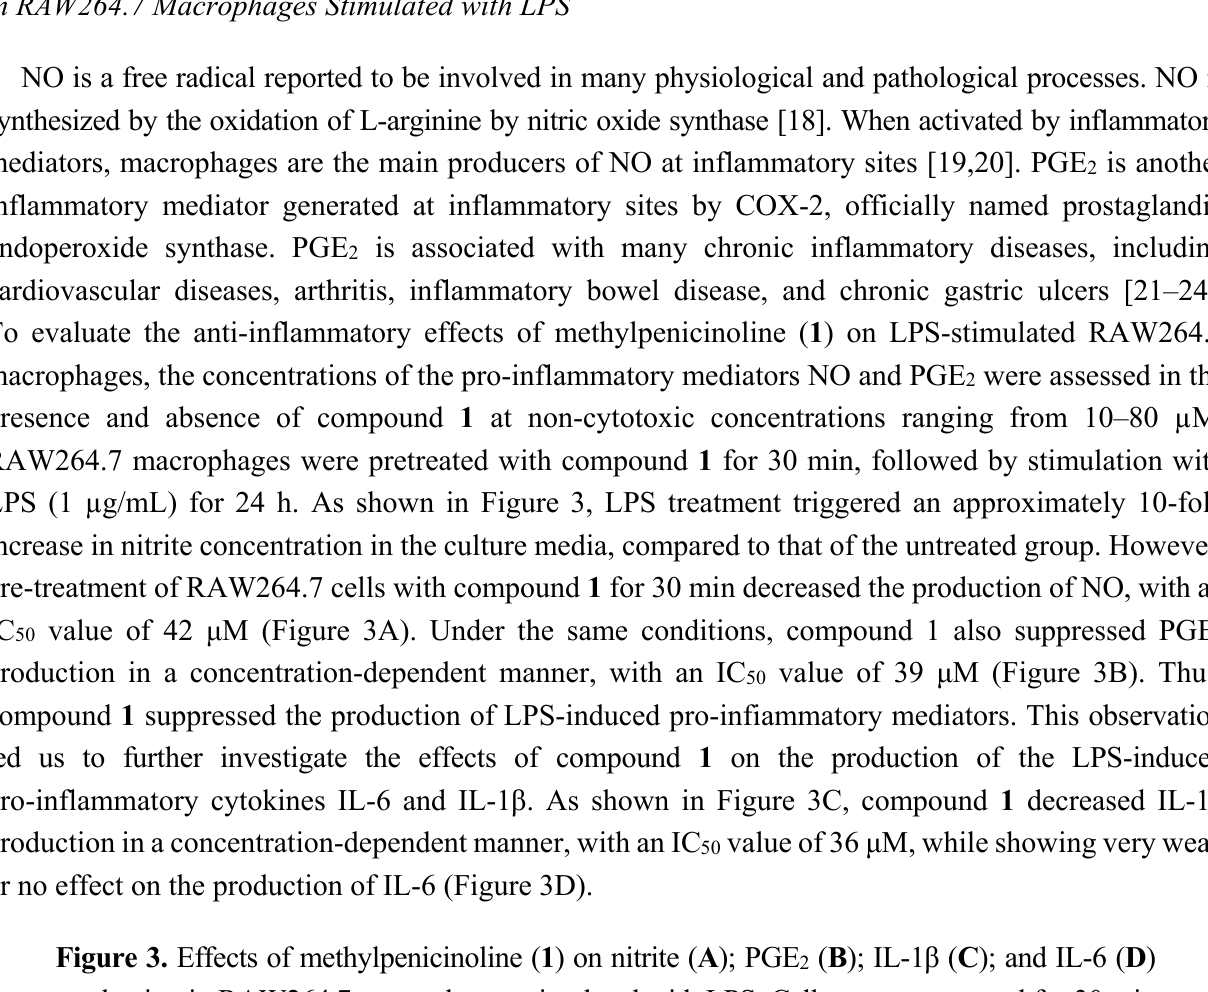
Figure 3. Effects of methylpenicinoline ( 1 ) on nitrite ( A ); PGE 2 ( B ); IL-1 β ( C ); and IL-6 ( D ) production in RAW264.7 macrophages stimulated with LPS. Cells were pre-treated for 30 min with indicated concentrations of 1 , and then stimulated for 24 h with LPS (500 ng/mL). The concentrations of nitrite (A); PGE 2 (B); IL-1 β (C); and IL-6 (D) were determined as described in Section 3.5. Data represent the mean values of three experiments ±